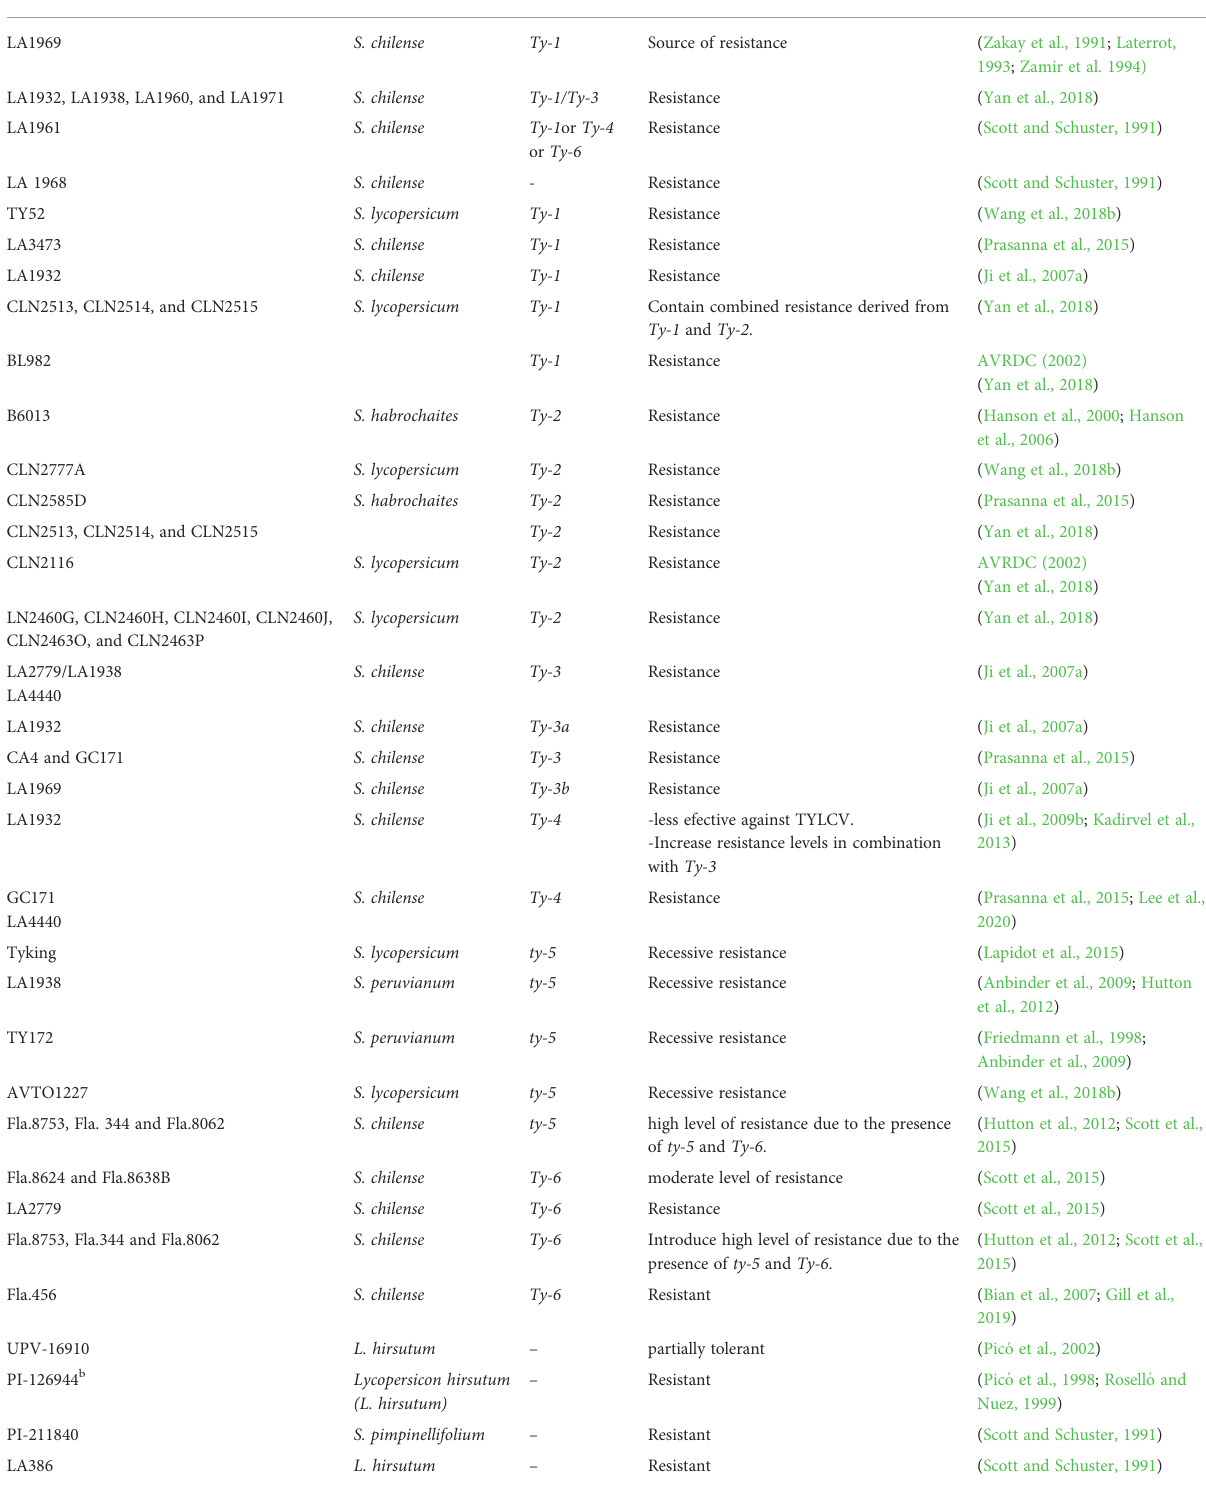
TABLE 1 Tomato resources resistance to TYLCV.